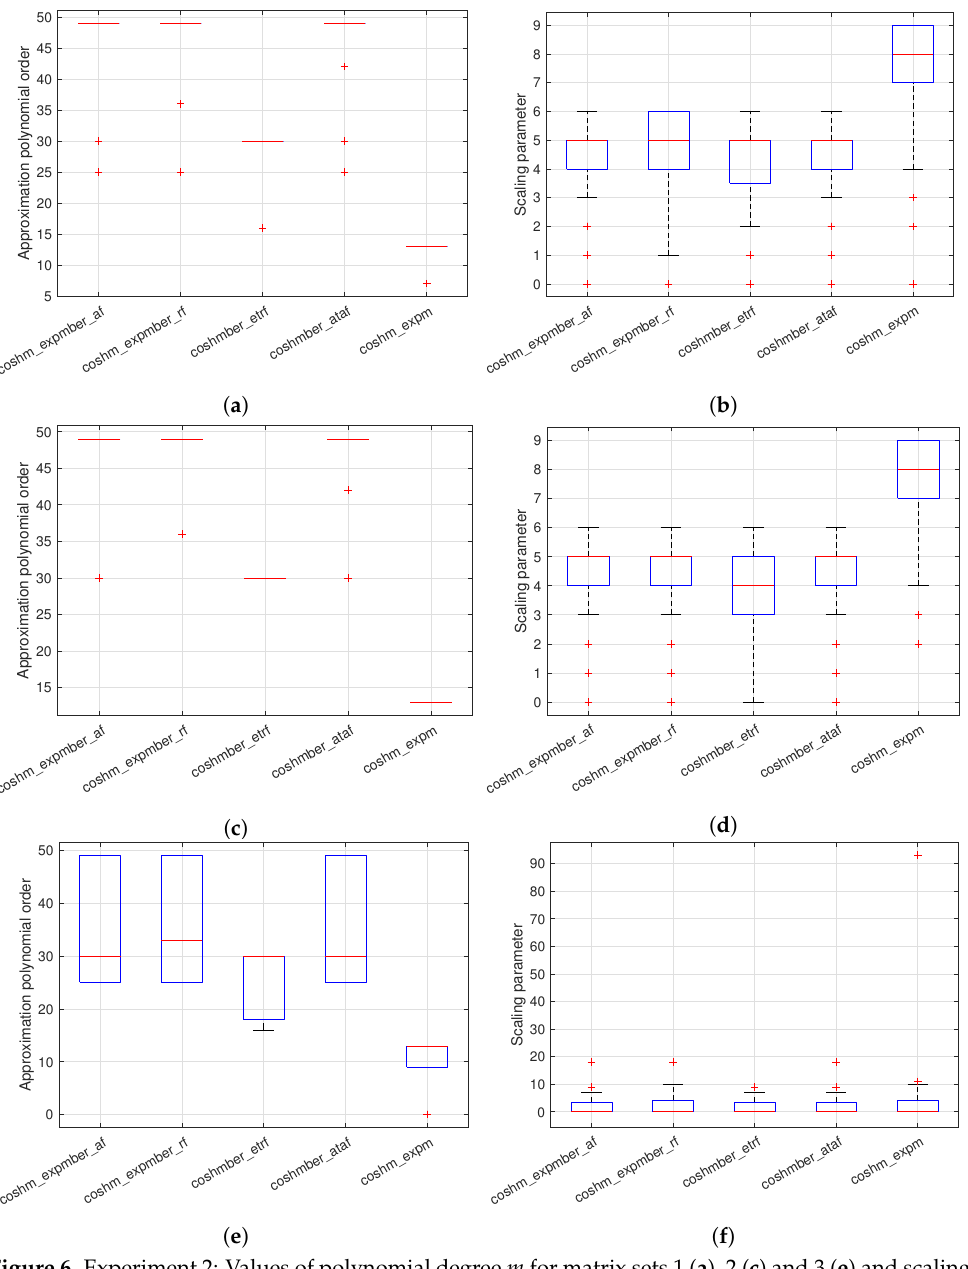
Figure 6. Experiment 2: Values of polynomial degree m for matrix sets 1 ( a ), 2 ( c ) and 3 ( e ) and scaling parameters s for the same sets ( b , d , f